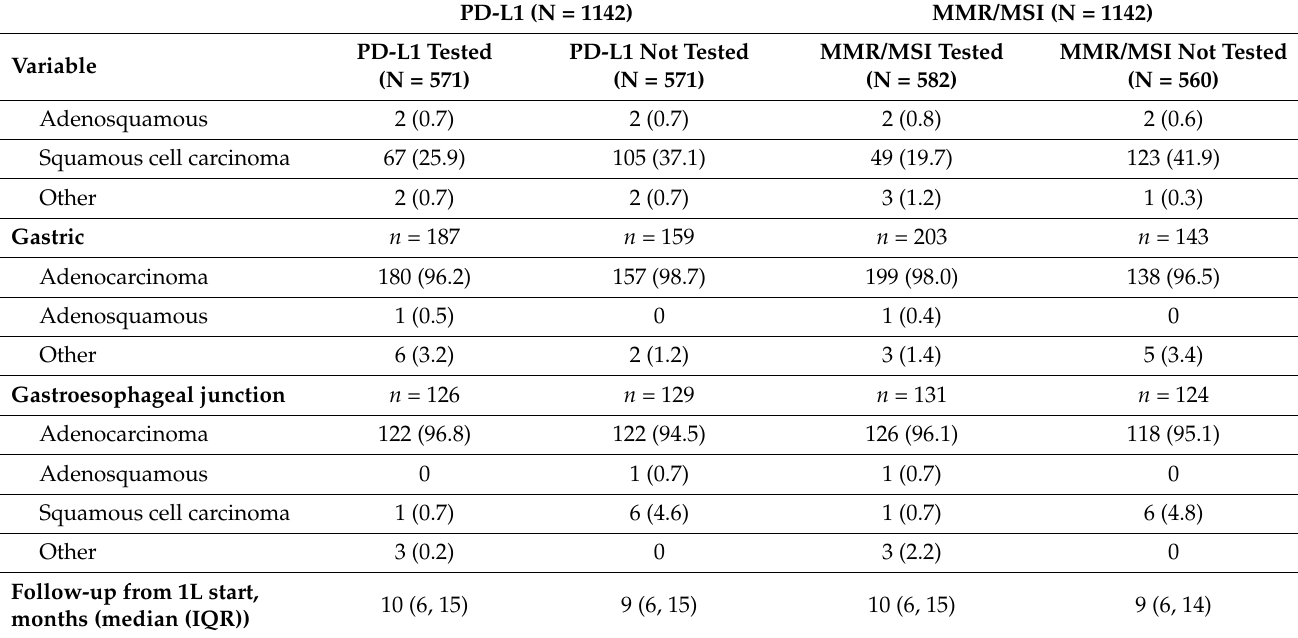
a Percentage based on primary tumor site. 1L, first-line. ECOG, Eastern Cooperative Oncology Group. IQR, interquartile range. MSI, microsatellite instability. MMR, mismatch repair. N, total number of patients. n , number of patients. PD-L1, programmed cell death-ligand